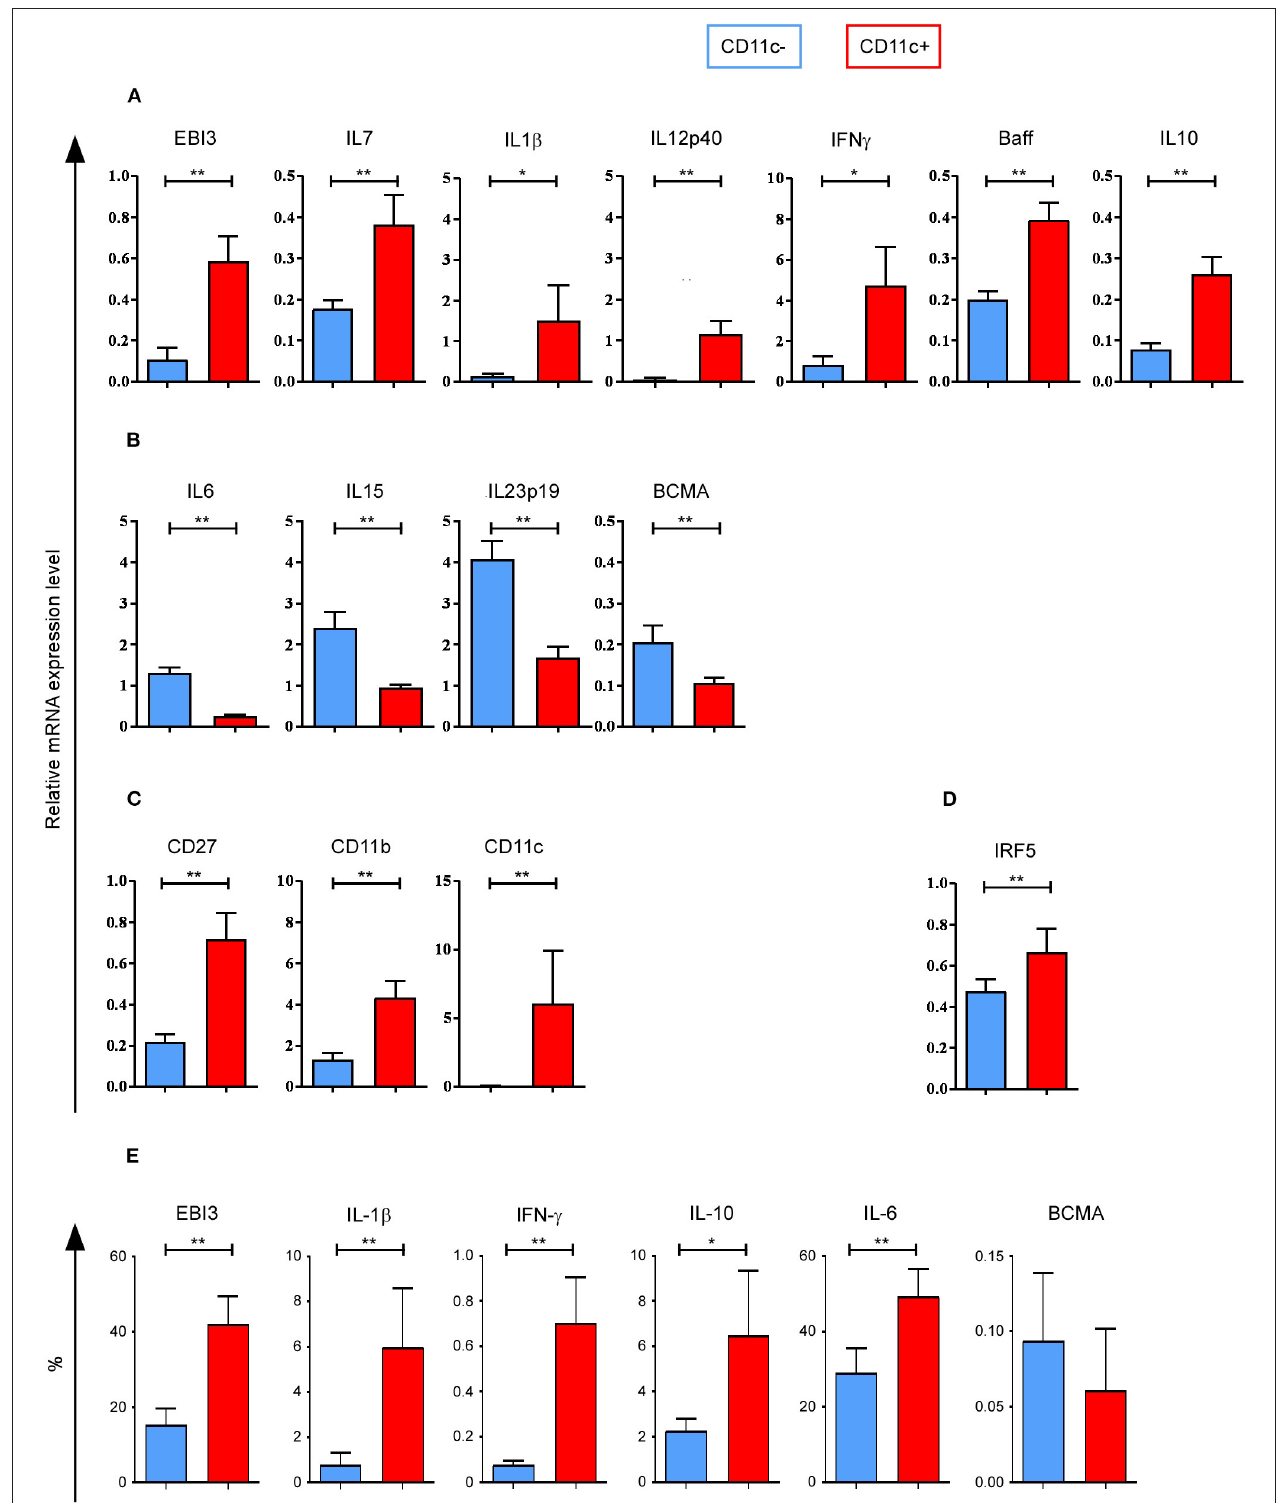
FIGURE 5 | Cytokine profile of CD11c + B cells as well as CD27, CD11b, CD11c, and IRF5 messenger RNA (mRNA) expression. Quantitative PCR (qPCR) analysis of cytokine genes for CD11c + and CD11c − B cells from 10 healthy donors (HD) shows (A) upregulated genes and (B) downregulated gene expression levels